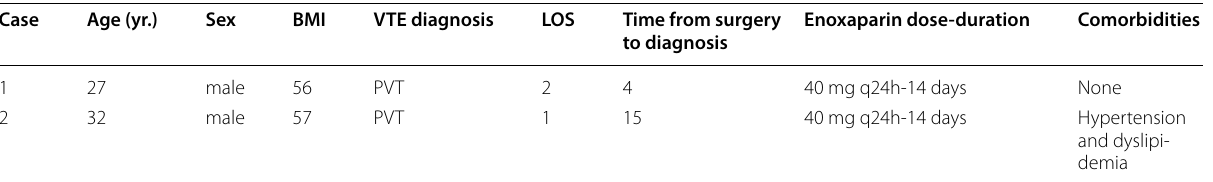
yr . year, BMI Body mass index, VTE Venous thromboembolism, PVT Portal vein thrombosis, LOS Length of hospital stay, q24h Once daily